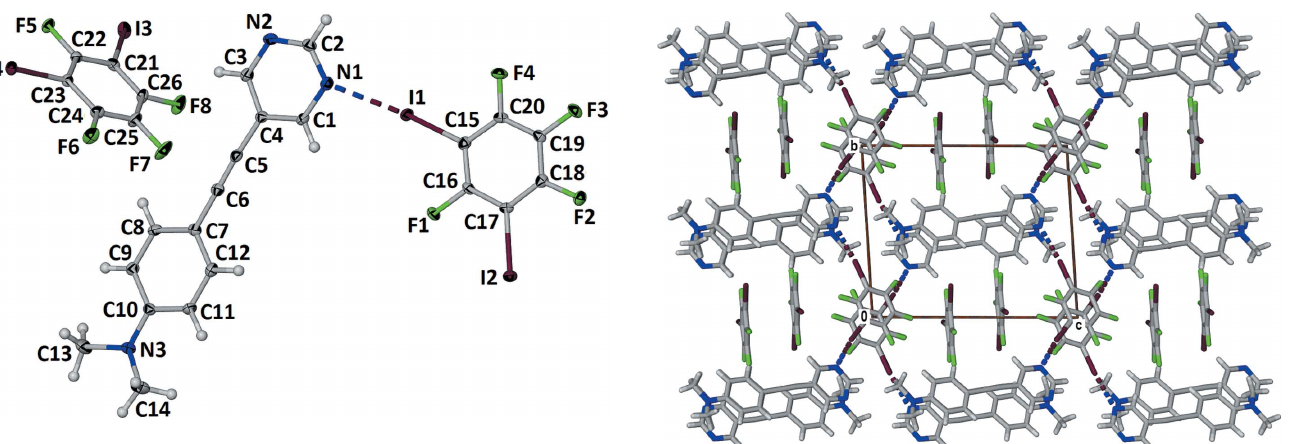
Figure 1 The molecular structure of the title compound with displacement ellipsoids drawn at 50% and the halogen bond shown as a dashed line.